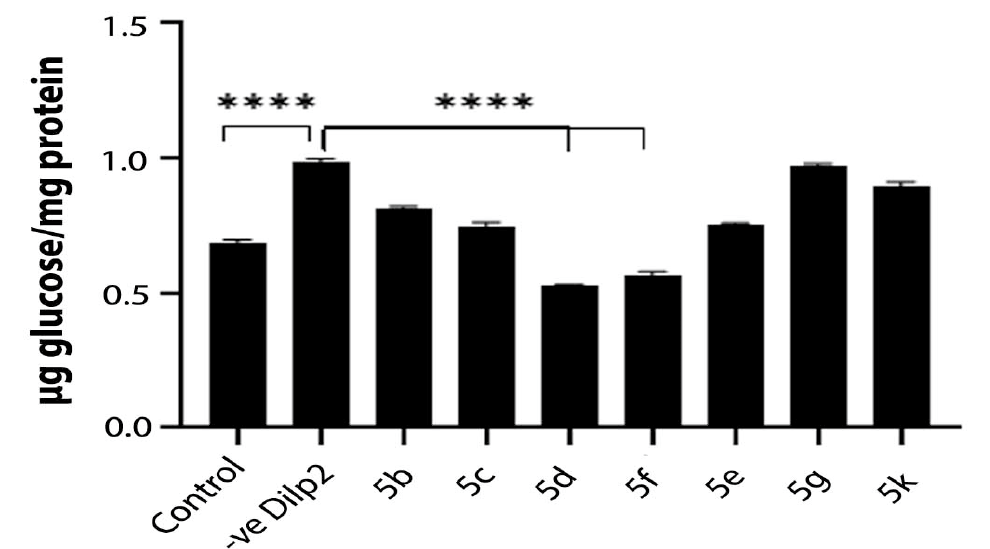
Figure 9. The TUNEL assay results after 48 h of treatment. ( A ) In comparison to the negative control group, the number of TUNEL-positive cells was significantly higher in 5b , 5d , and 5m compounds (original magnification 20 µm). As a counterstain, DAPI staining was applied. ( B ) Relative quantification of FITC (green) expression of 5b, 5d, and 5m in comparison to negative control. The mean and standard deviation of two independent experiments is reported (** p < 0.01). Where, PC–positive control and NC–negative control.